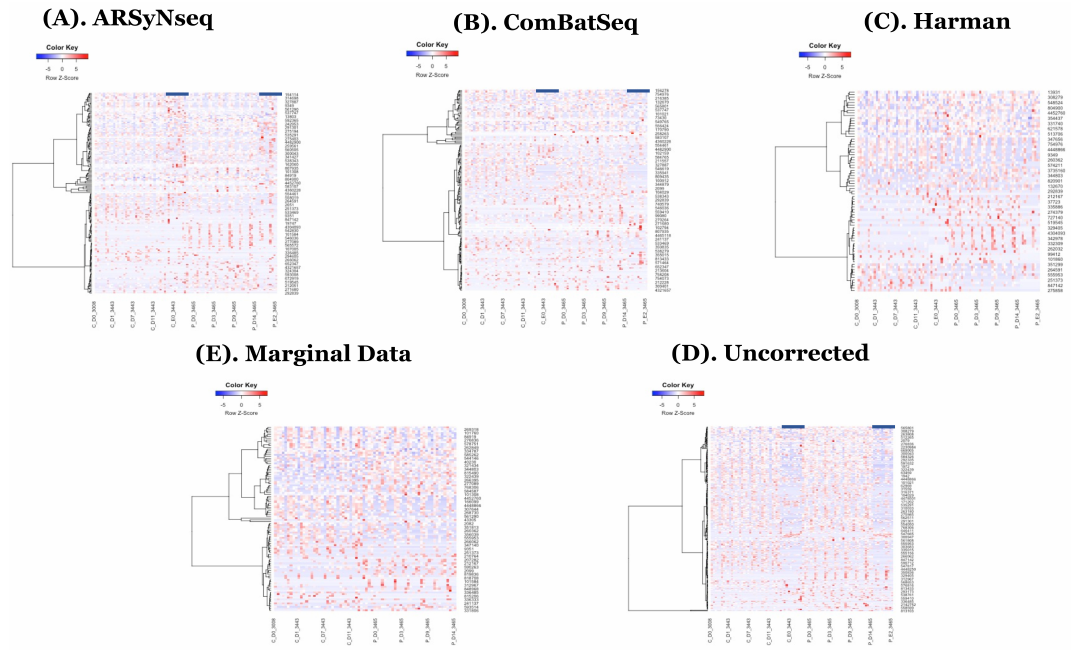
Figure 4. ( A – E ) show the heatmaps generated by the complementary sets of core-intersection sets from 5 different types of batch handling procedures (ARSyNseq, ComBatSeq, Harman, Uncorrected, and Marginal Data) in clockwise from top-left. Note that blue bars indicate samples that still show batch effect in two corrected datasets (ARSyNSeq and ComBatSeq) and uncorrected